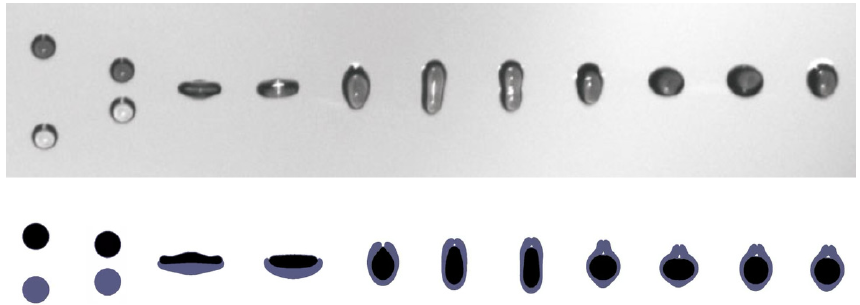
Figure 3. Snapshots and simulation images of the head-on collision process of immiscible droplets.